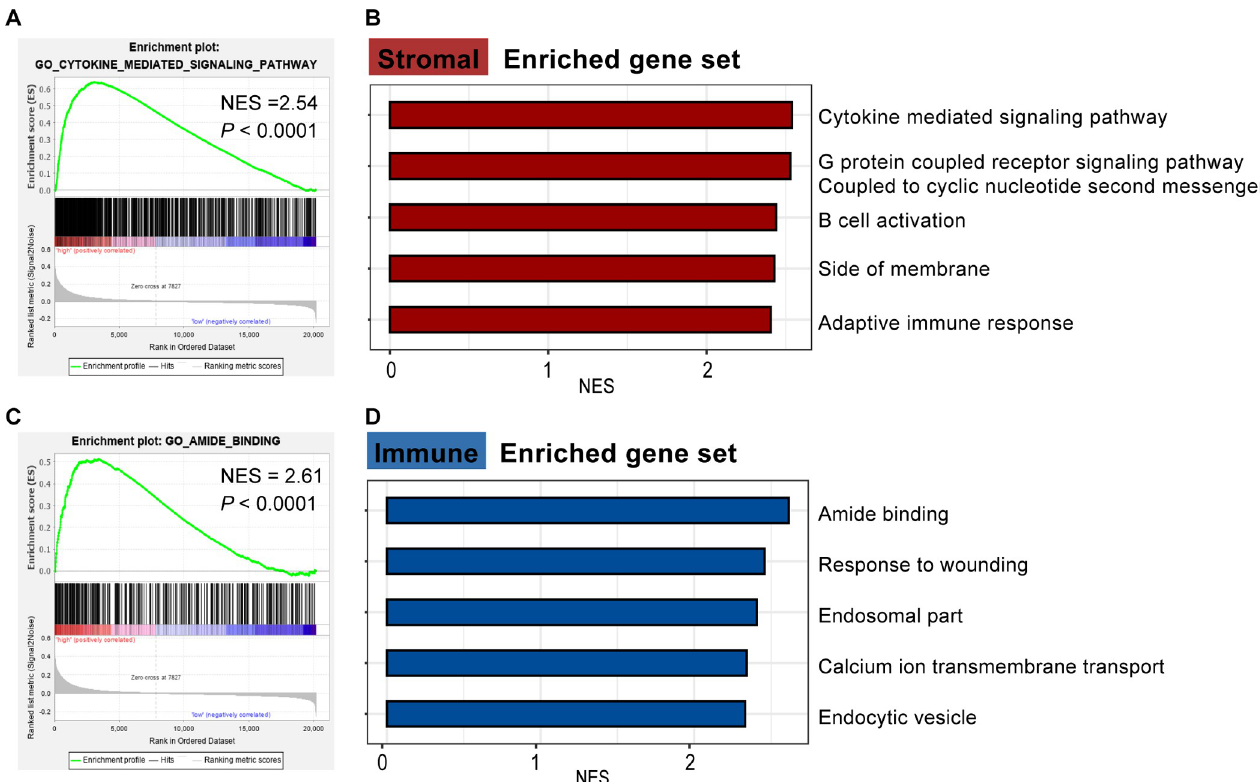
Fig 2. Estimate score C5 enrichment analysis results based on the ESTIMATE algorithm. (A) GSEA of top one pathway enriched for high stromal group (NES = 2.54, nominal P < 0.0001). (B) The top5 significant biological pathways in high stromal score group (sort by NES). (C) The enrichment plot of amide binding (NES = 2.61, nominal P < 0.0001). (D)The top5 significant biological pathways in high immune score group (sort by